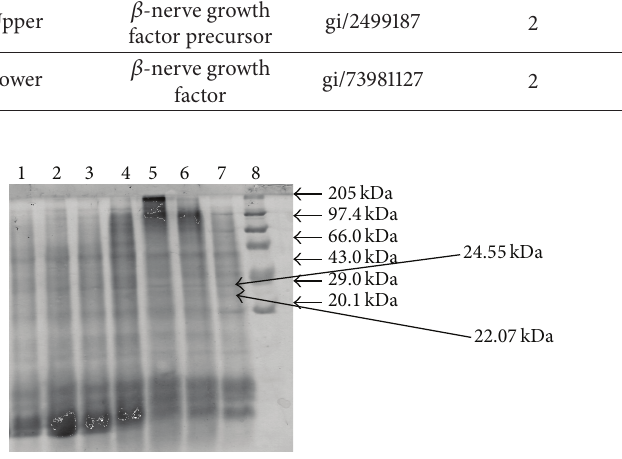
Figure 3: Protein profiles of fresh and liquefied semen. Lane 1, 0 hours; lane 2, 6 h; lane 3, 12h; lane 4, 18h; lane 5, 24 h; lane 6, 30 h; lane 7, 36 h; lane 8, 42 h; lane 9, 48 h; lane 10, 54h; lane 11, 60h; lane 12, 66h; lane 13, 72 h; lane 14, 84 h; and lane 15, protein markers.